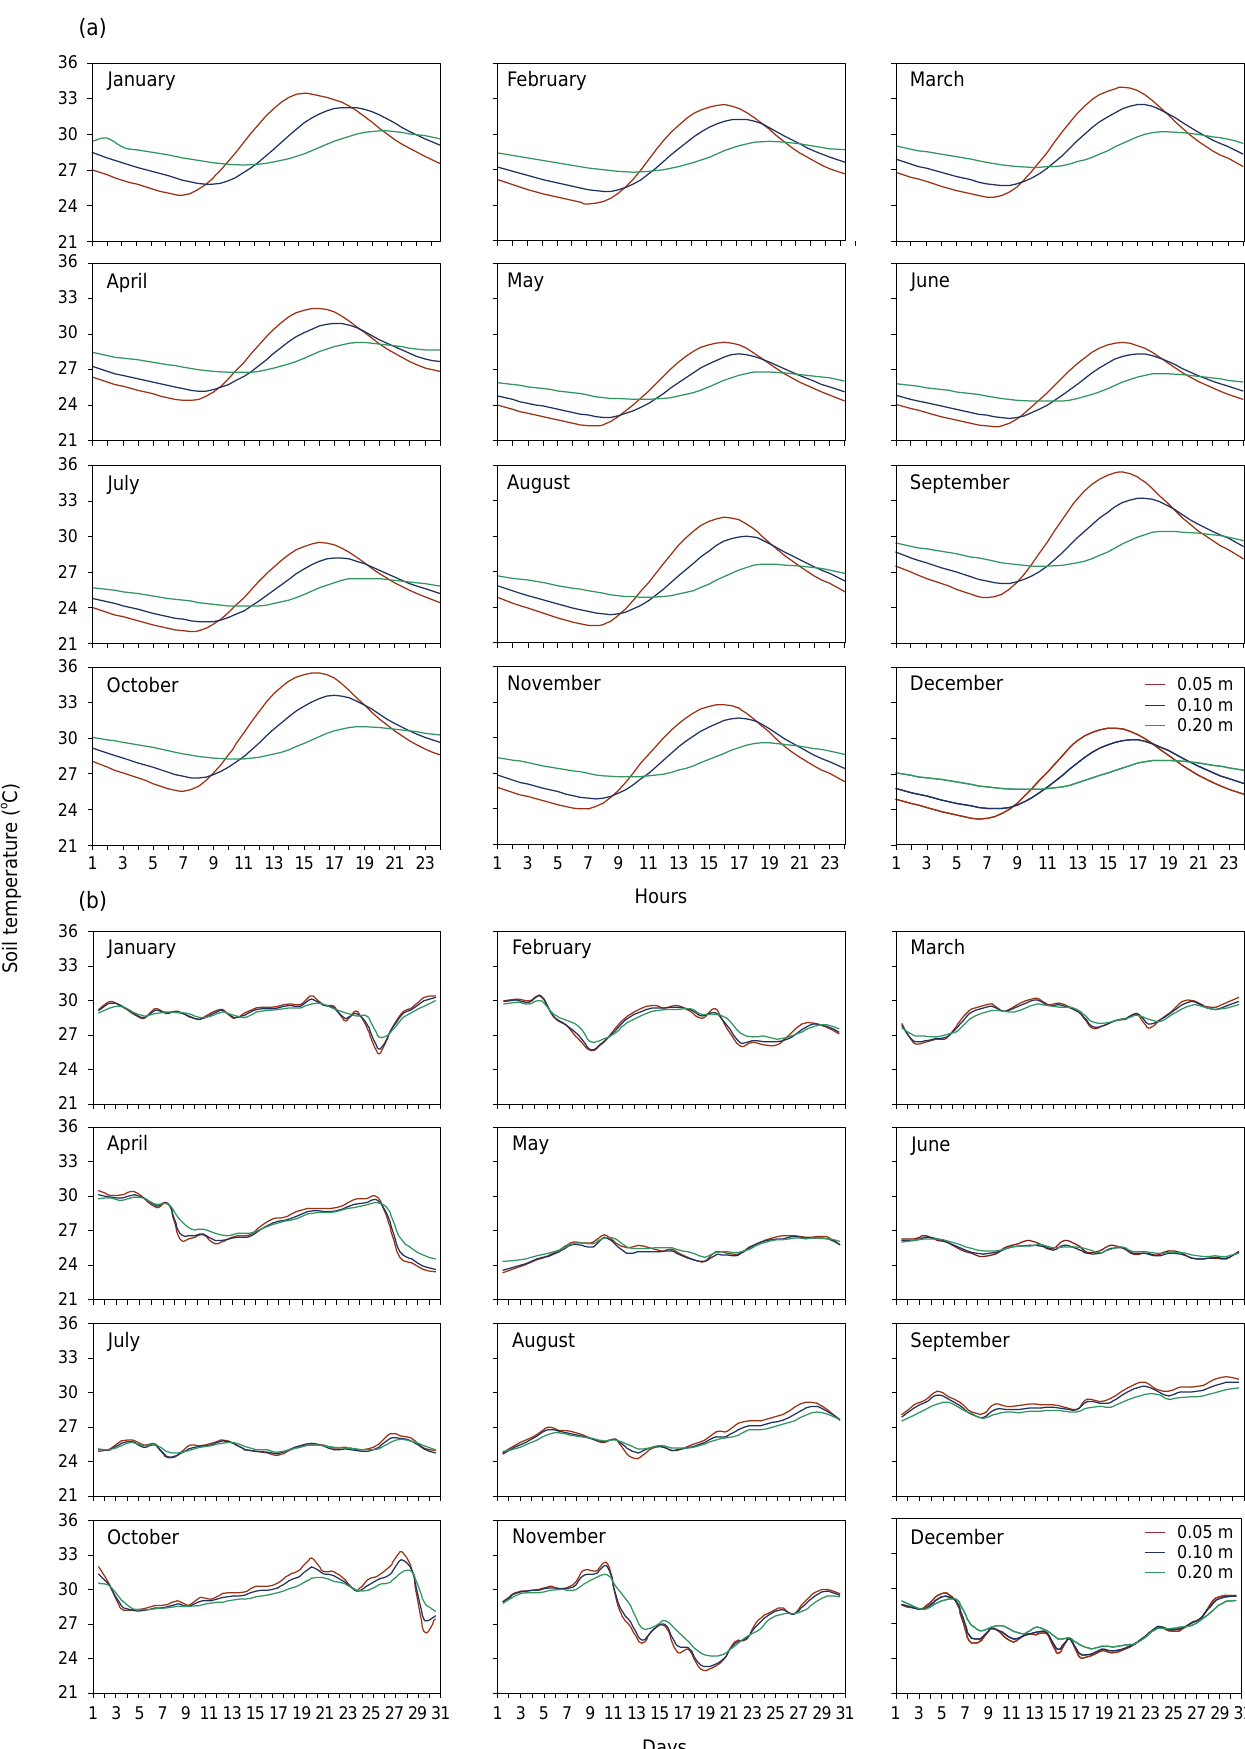
Figure 2. The hourly (a) and daily (b) monthly mean of soil temperature at three different depths of a Cambissolo Háplico Ta Eutrófico (Cambisol; Inceptisol), from February 04, 2014, to September 30, 2015, in São Gabriel, Irecê Identity Territory, Bahia,